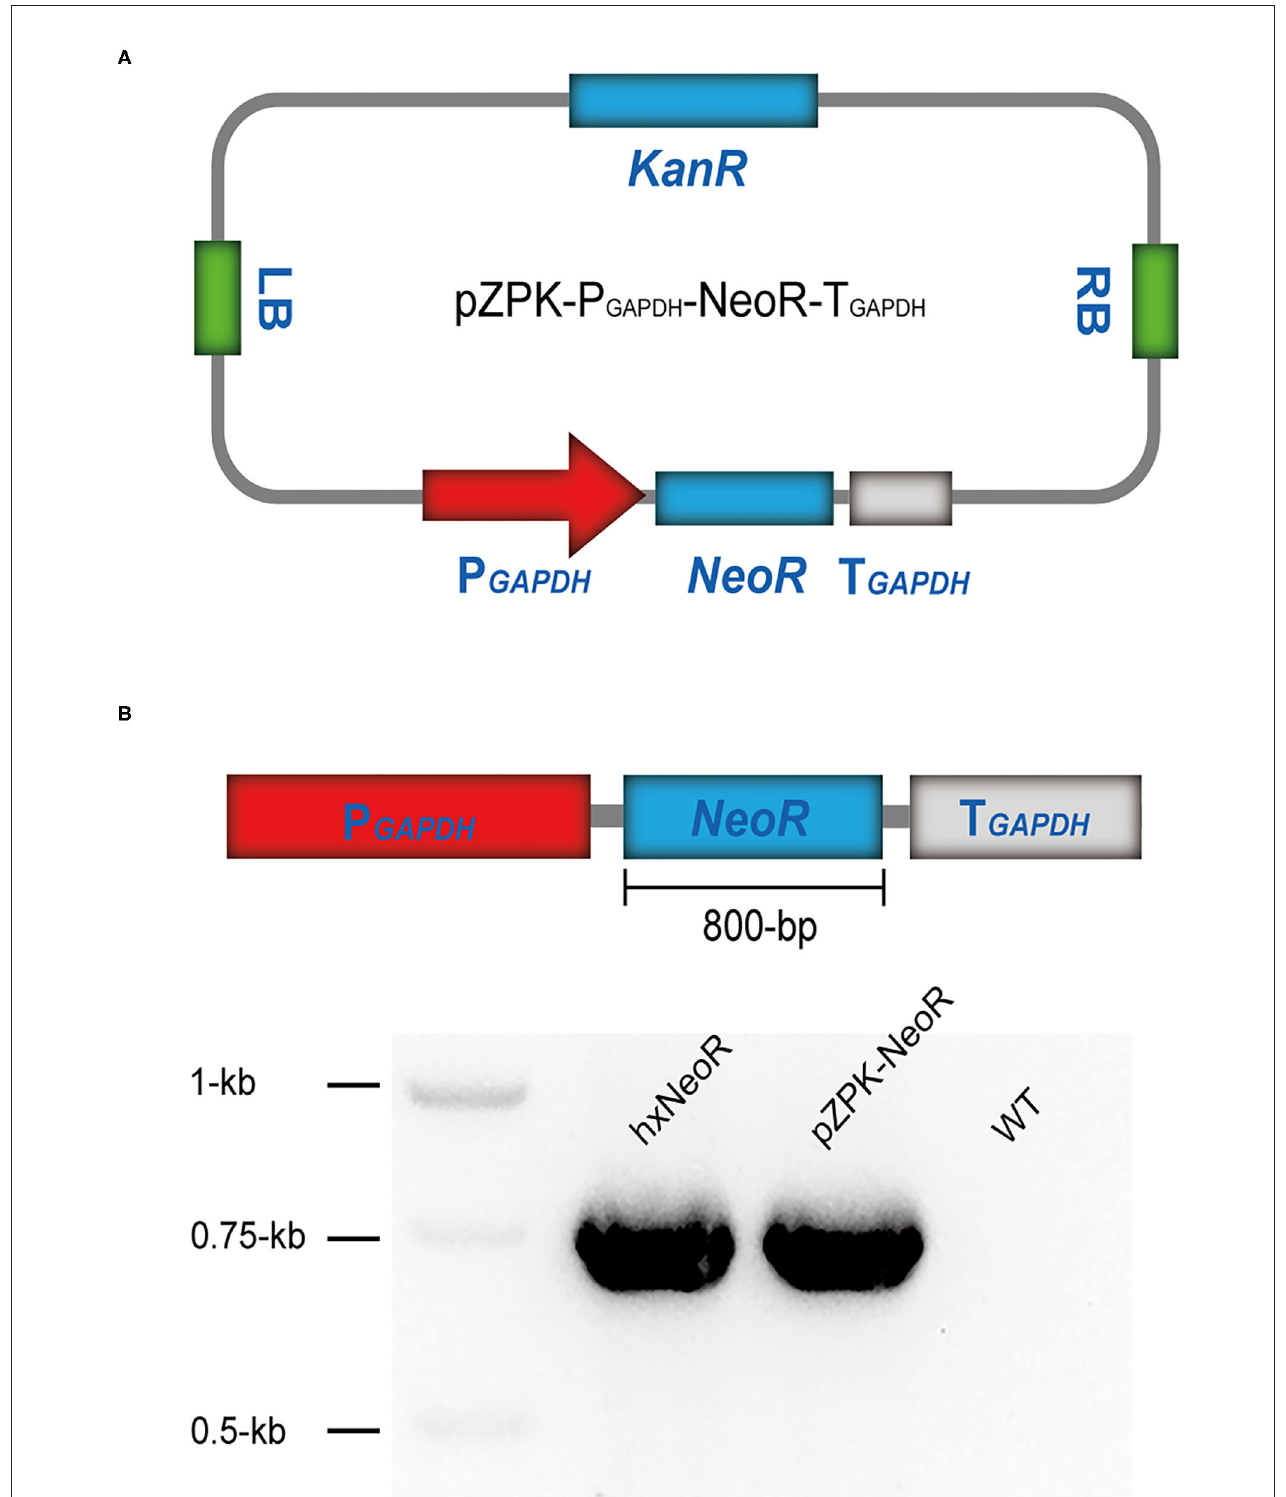
FIGURE 1 | The construction of the plasmid pZPK-P GAPDH -NeoR-T GAPDH and the transformation of HX-308. (A) Map of the plasmid pZPK-P GAPDH -NeoR-T GAPDH . (B) The schematic diagram of the NeoR expression cassette and diagnostic PCR validation of the NeoR gene.